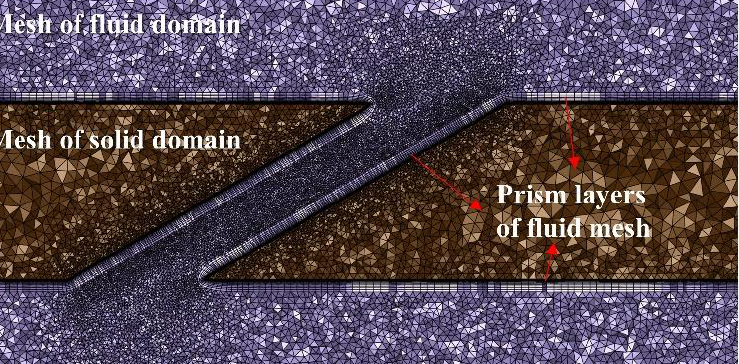
Figure 3. Mesh generated near the film hole at α = 30° with purple representing the fluid domain mesh and brown representing the solid domain mesh.